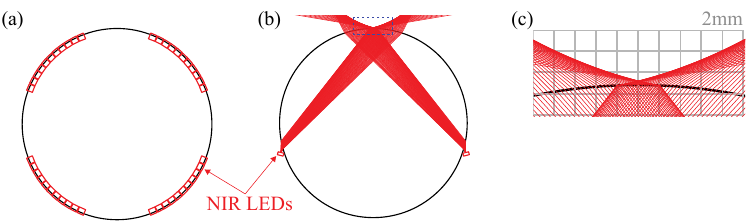
Figure 2. The illumination system for behavior imaging. ( a ) The top view of the NIR LEDs (red rectangle), 40 LEDs (a set of 10 LEDs in every 90°) are installed around the sphere. ( b ) The side view of the illumination system and simulation of ray-tracing (red lines) of 2 LEDs only shown. ( c ) The detailed results of ray-tracing simulation in the dotted box in ( b ).